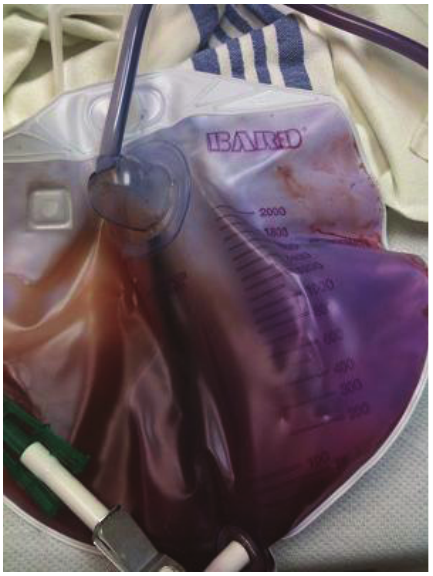
Figure 2: Purple discoloration of the urine with similar changes in the urine bag and